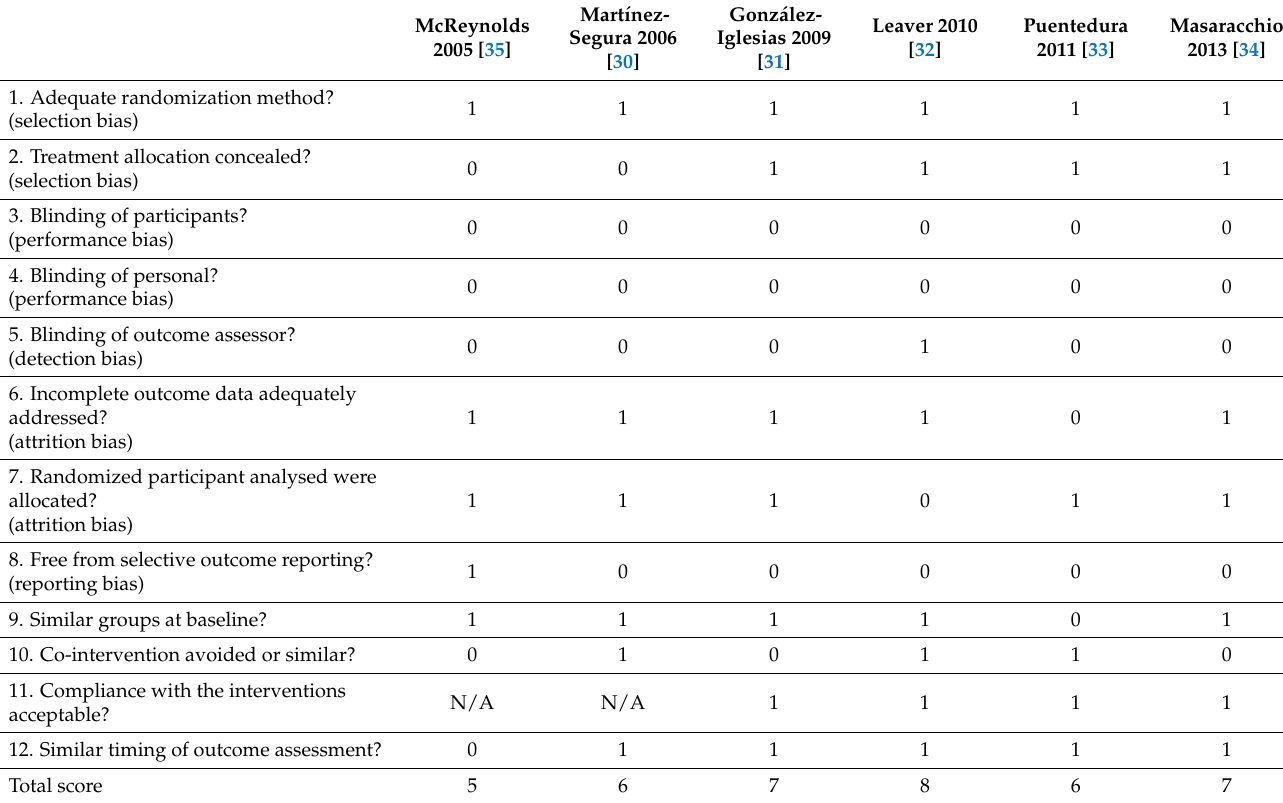
Table 1. The methodological quality scores (maximum score 12 points) based on the Cochrane Back and Neck (CBN) Risk of Bias tool. Low risk of bias are scores ≥ 6, while high risk of bias are scores < 6. Yes answers = 1 point and no answers = 0 point. N/A not